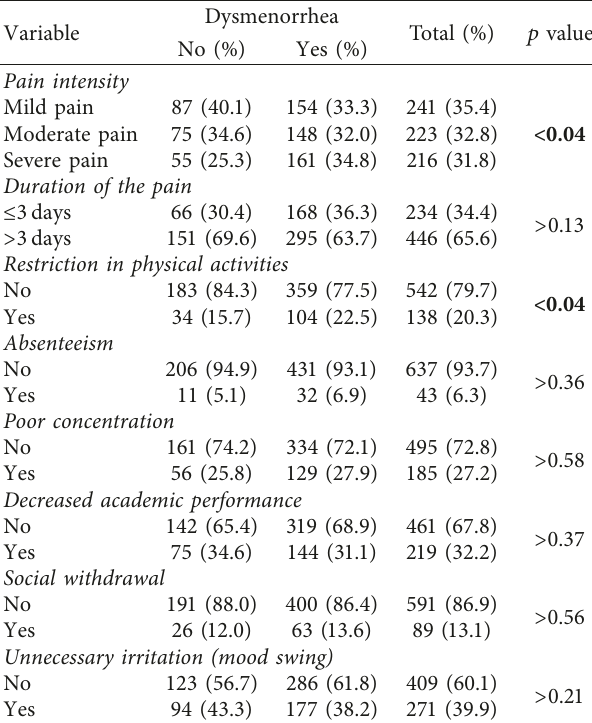
Table 2: Multiple logistic regression results modeling self-reported